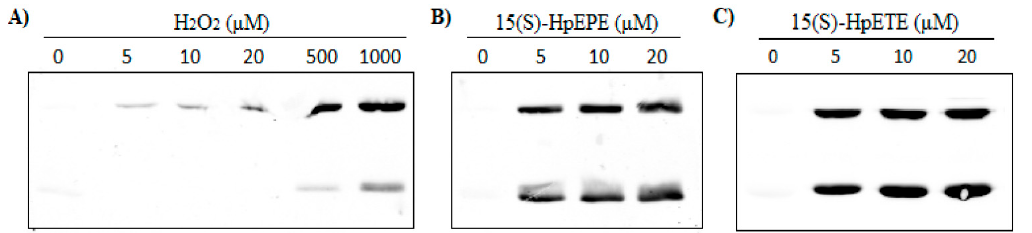
Figure 4. Hyperoxidation of Hs Prx3 by different hydroperoxides. Reduced Hs Prx3 (5 µM) was treated with the indicated concentrations of ( A ) H 2 O 2 ; ( B ) 15(S)-HpEPE; and ( C ) 15(S)-HpETE in sodium phosphate buffer 50 mM pH 7.8 plus 0.1 mM DTPA. The samples were alkylated and used for Western Blot detection of Cys P hyperoxidation.